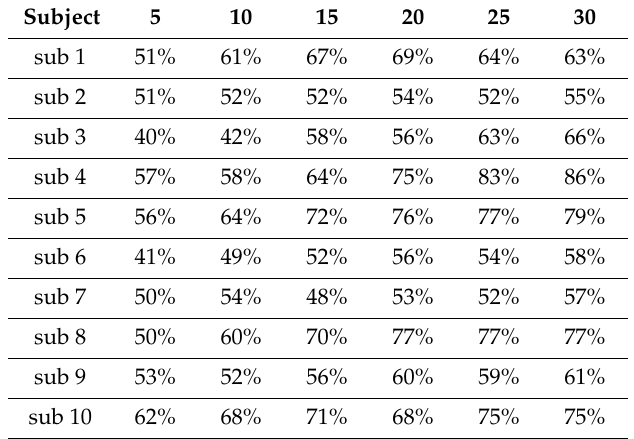
Table 3. Mental workload classification accuracy (%) with di ff erent numbers of ICs in Method 1.